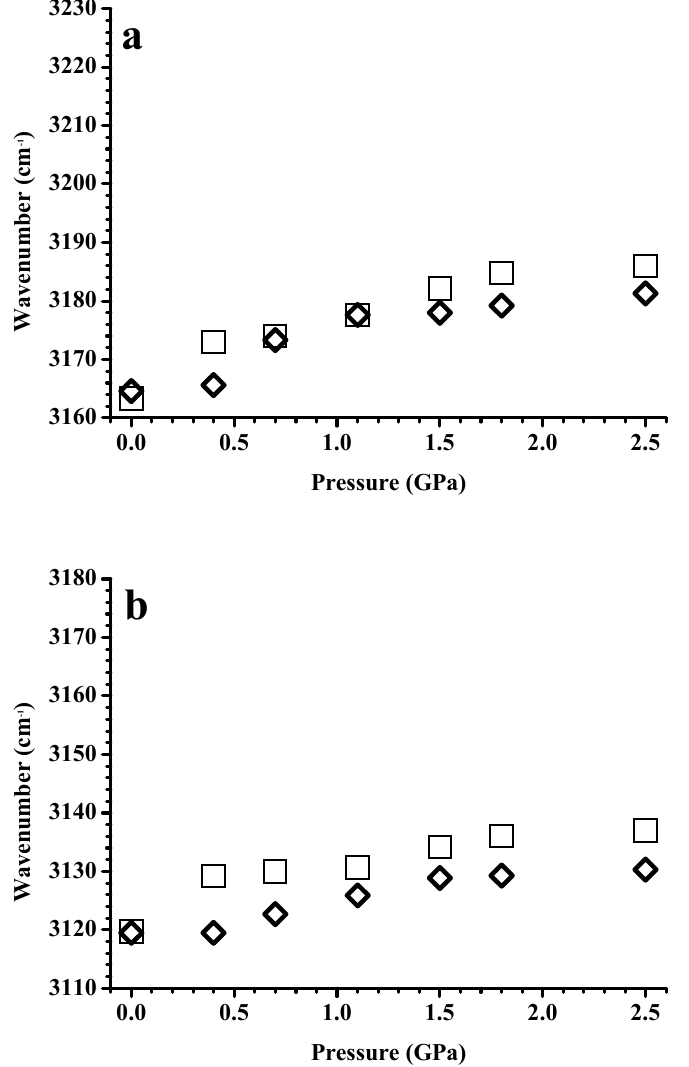
Figure 7. Pressure dependence of the C-H stretching frequencies at ( a ) 3163 and ( b ) 3120 cm − 1 of the pure [C 4 C 1 Im][BF 4 ] (squares) and [C 4 C 1 Im][BF 4 ] in a silica matrix (diamonds).